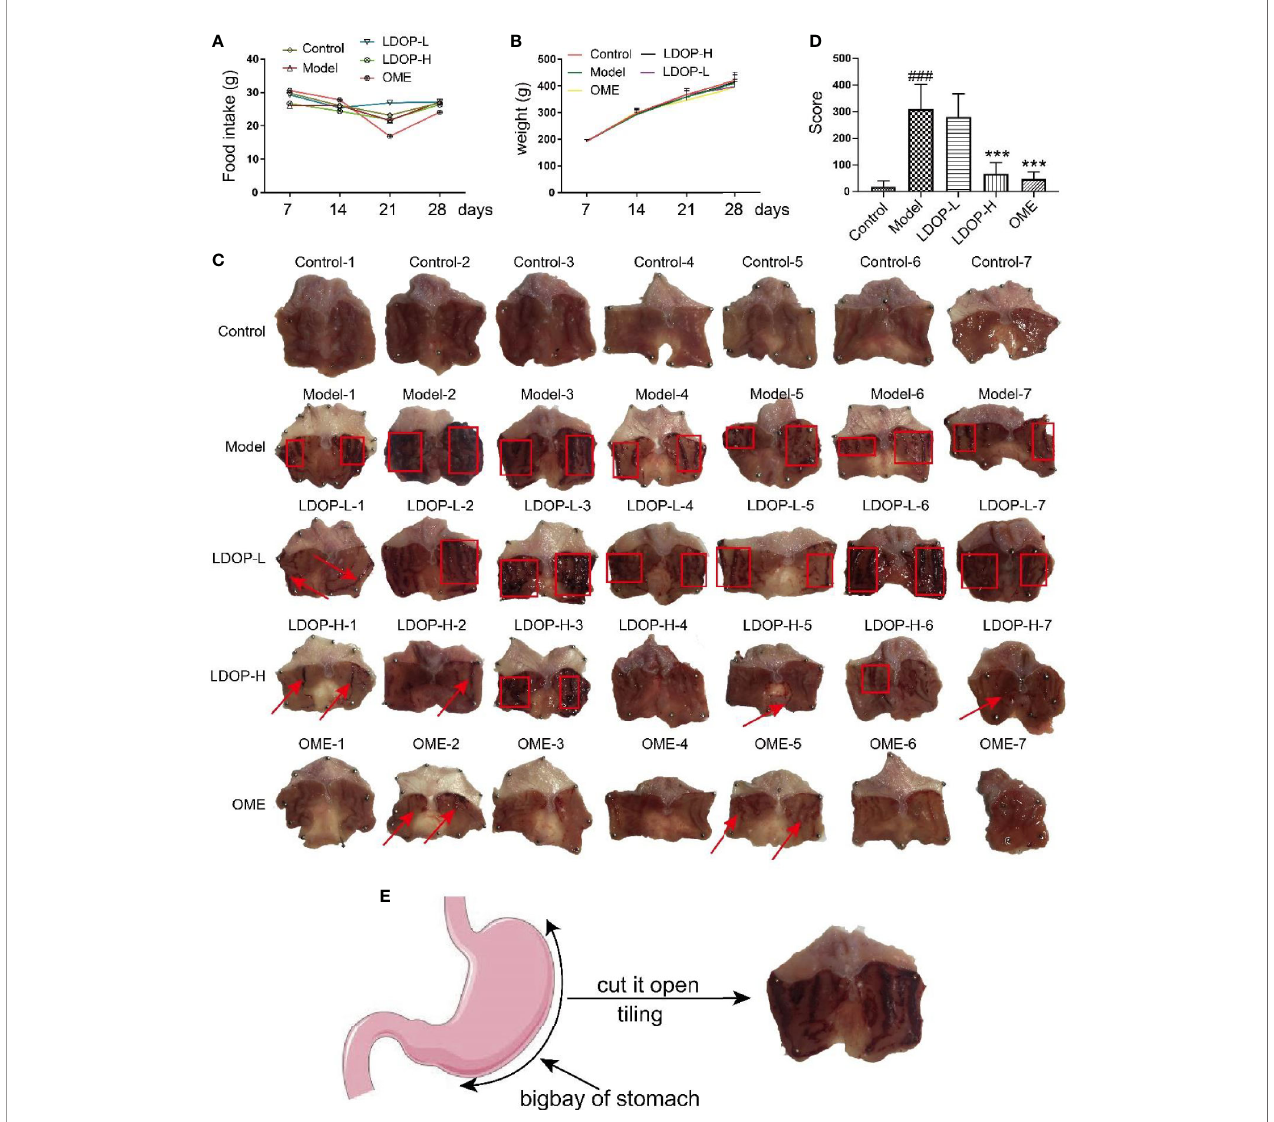
FIGURE 2 | Effects of LDOP-1 on food intake and weight, as well as the macroscopic images of the gastric mucosal damage and injury score in the rat subjected to ethanol-induced gastric ulcer. Food intake (A) and weight (B) of rats were measured once a week. The images of gastric mucosal tissues (C) were quanti fi cation by the injury score, red rectangle stand for Bleeding zone, red arrow stand for Bleeding point. (D) . Data are expressed as the mean±SD of three independent experiments. (E) . Pattern diagram of stomach anatomy. ### P < 0.001 compare the control group; ***P < 0.001 compare model group. LDOP-L stood for LDOP-1-L, LDOP-H stood for